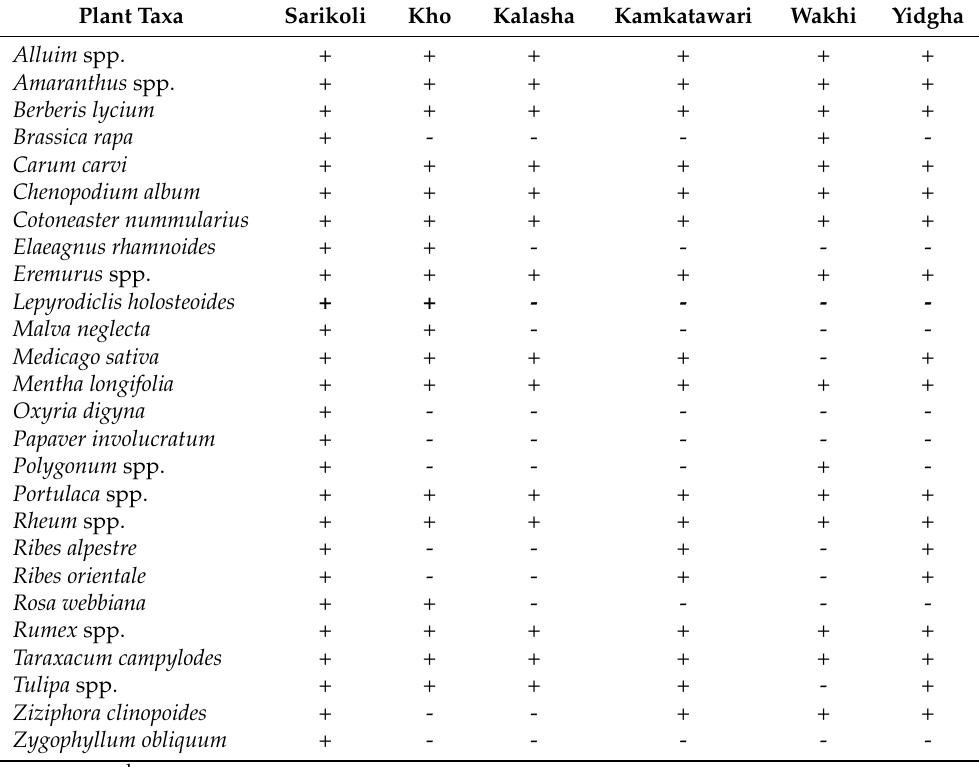
Table 3. Presence-absence index for the plants reported among the seven researched groups in Chitral